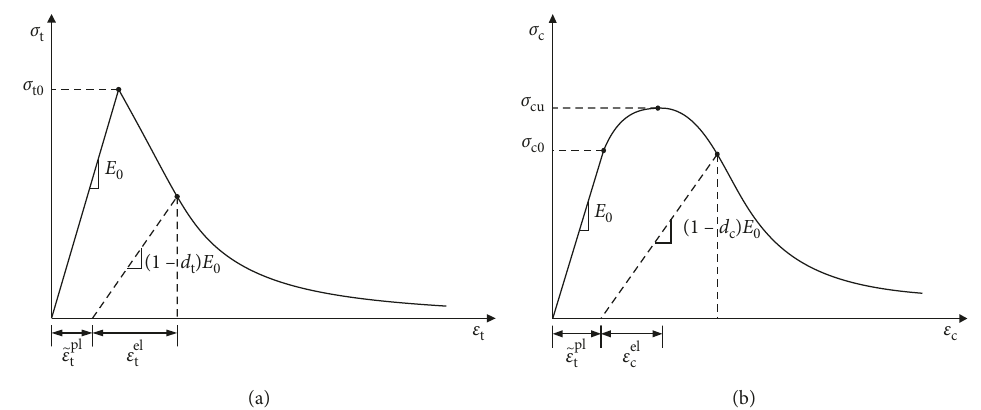
Figure 1: Stress and strain curves (a) uniaxial tensile rock mass and (b) uniaxial compression rock